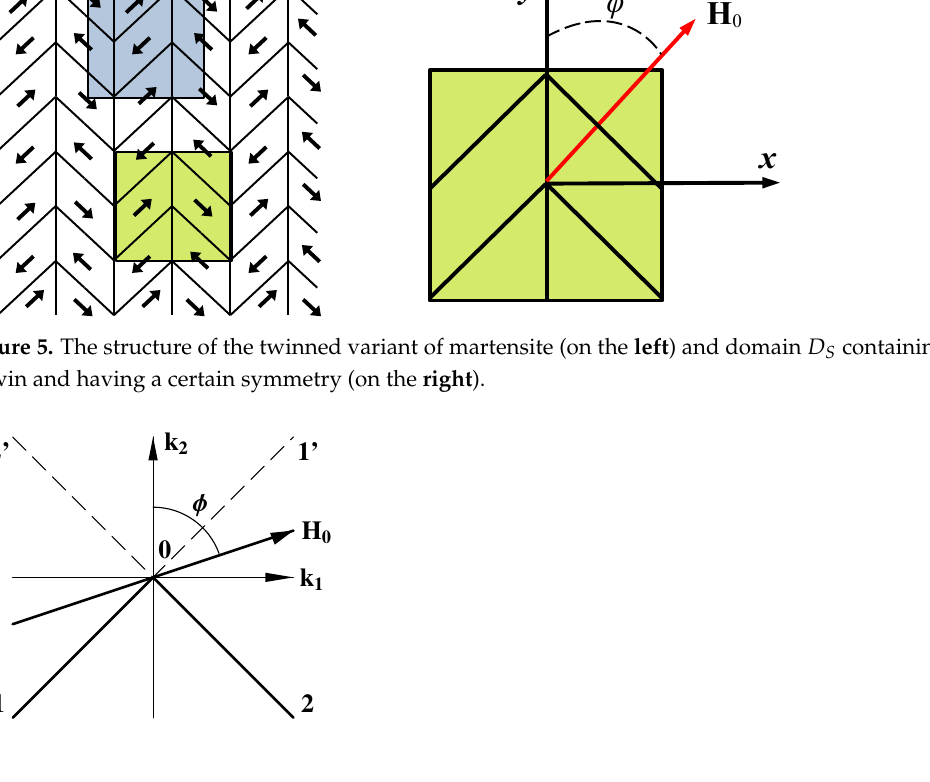
Figure 6. The magnetic structure of symmetrical domain D S . H 0 is a strength vector of the external magnetic field applied to the domain at an angle φ